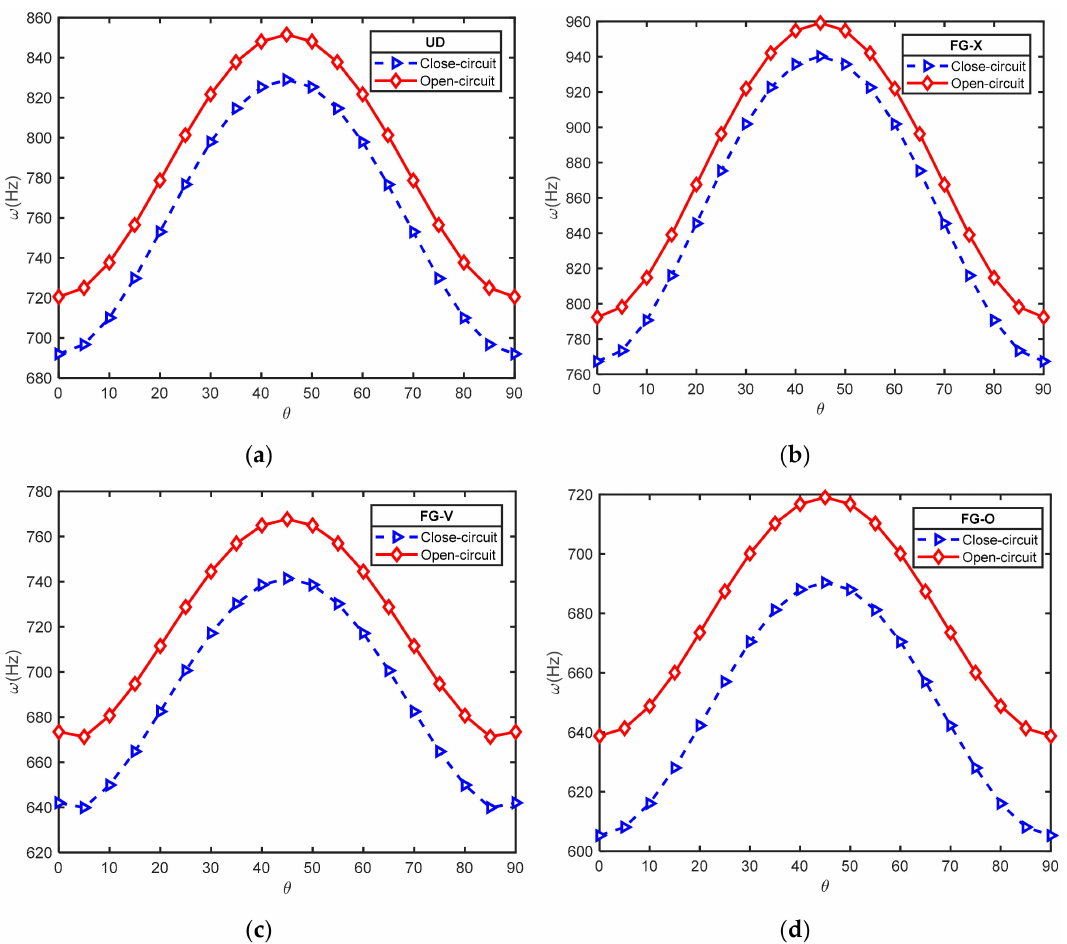
Figure 3. E ff ect of lamination angle on natural frequency of laminated FG-CNTRC plates [p / ( − θ / θ ) 3 / p] with electrical condition ( a = b = 0.4m; a / h = 20; V * CNT = 0.28): ( a ) UD; ( b ) FG-X; ( c ) FG-V; ( d ) FG-O.